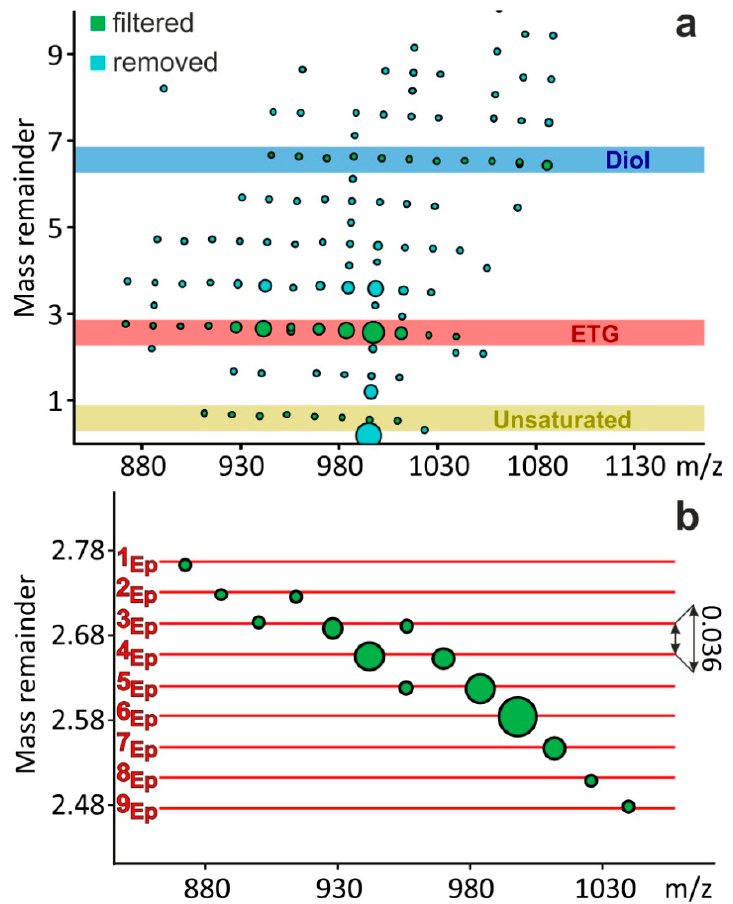
Figure 2. ( a ) Mass-remainder (MR) versus m / z plot, and ( b ) zoomed MR versus m / z plot of the MALDI-TOF mass spectrum of the epoxidized soybean oil. ETG stands for the epoxidized triglycerides with no remaining double bonds. The size of the larger dots indicates peak intensity. For the sake of visibility, a minimum dot-size was used, therefore the sizes of the unsaturated and diol dots are exaggerated, and do not reflect the real intensity ratios.